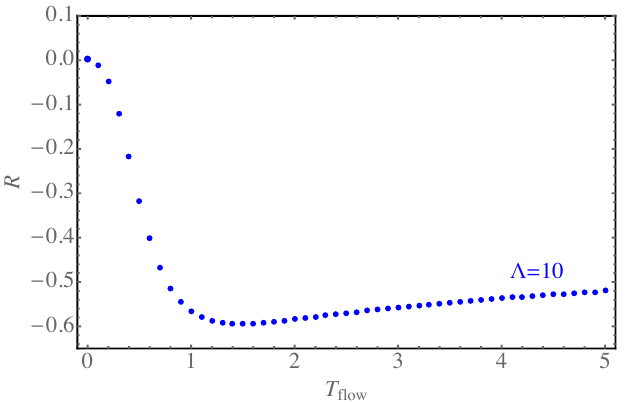
Figure 7 . T (cid:13)ow -dependence of the reweighting factor at (cid:3) = 10 for the Gaussian model for p = 2, (cid:11) = 3, and (cid:12) =